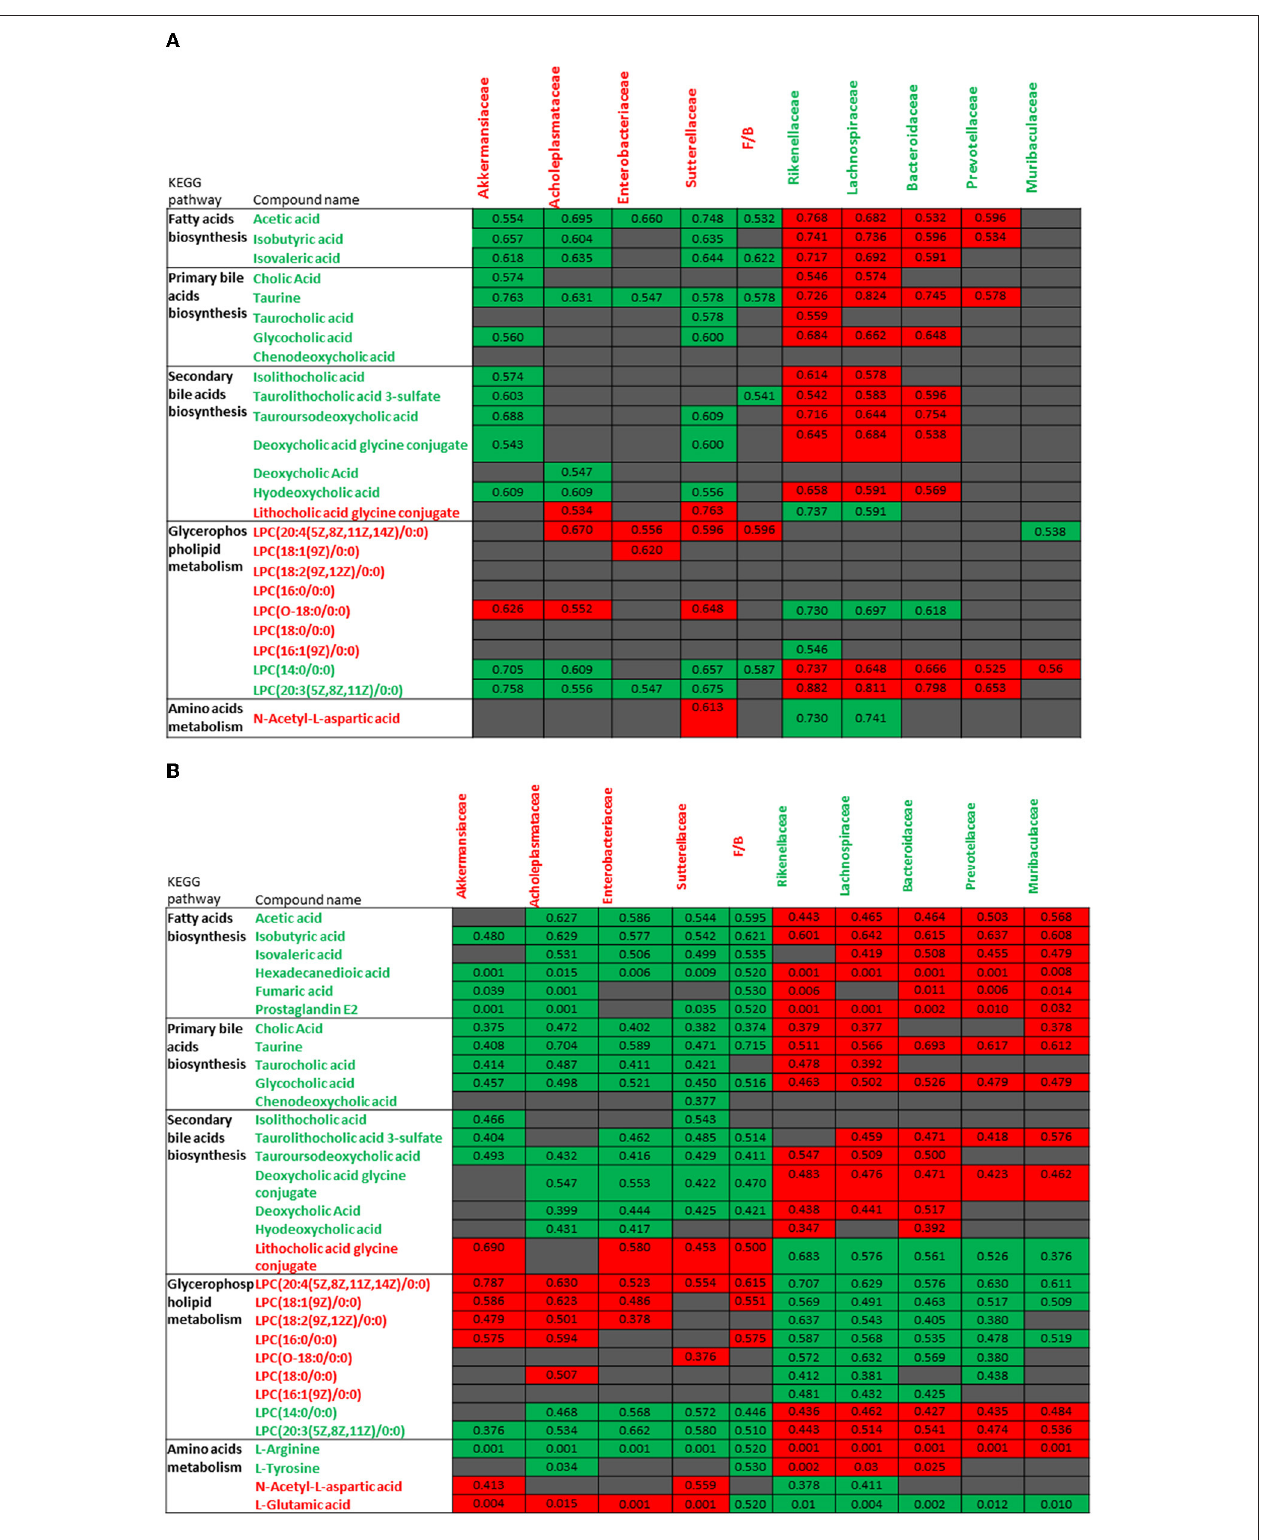
FIGURE 9 | Correlations between the changes in metabolites of vancomycin treatment group 1 (A) and vancomycin treatment groups 2 and 3 (B) and abundances in different bacterial families. The number in color present Spearman’s correlation coefficient: red color indicates positive correlation; green color indicates negative